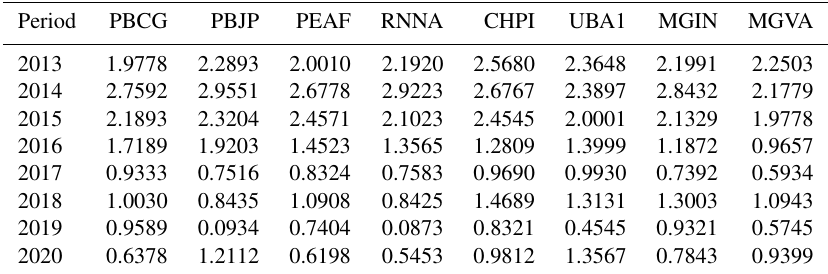
Table 3. Summary of the averaged maximum DIX values attributed to plasma bubble events selected from 2013 to 2020 for the